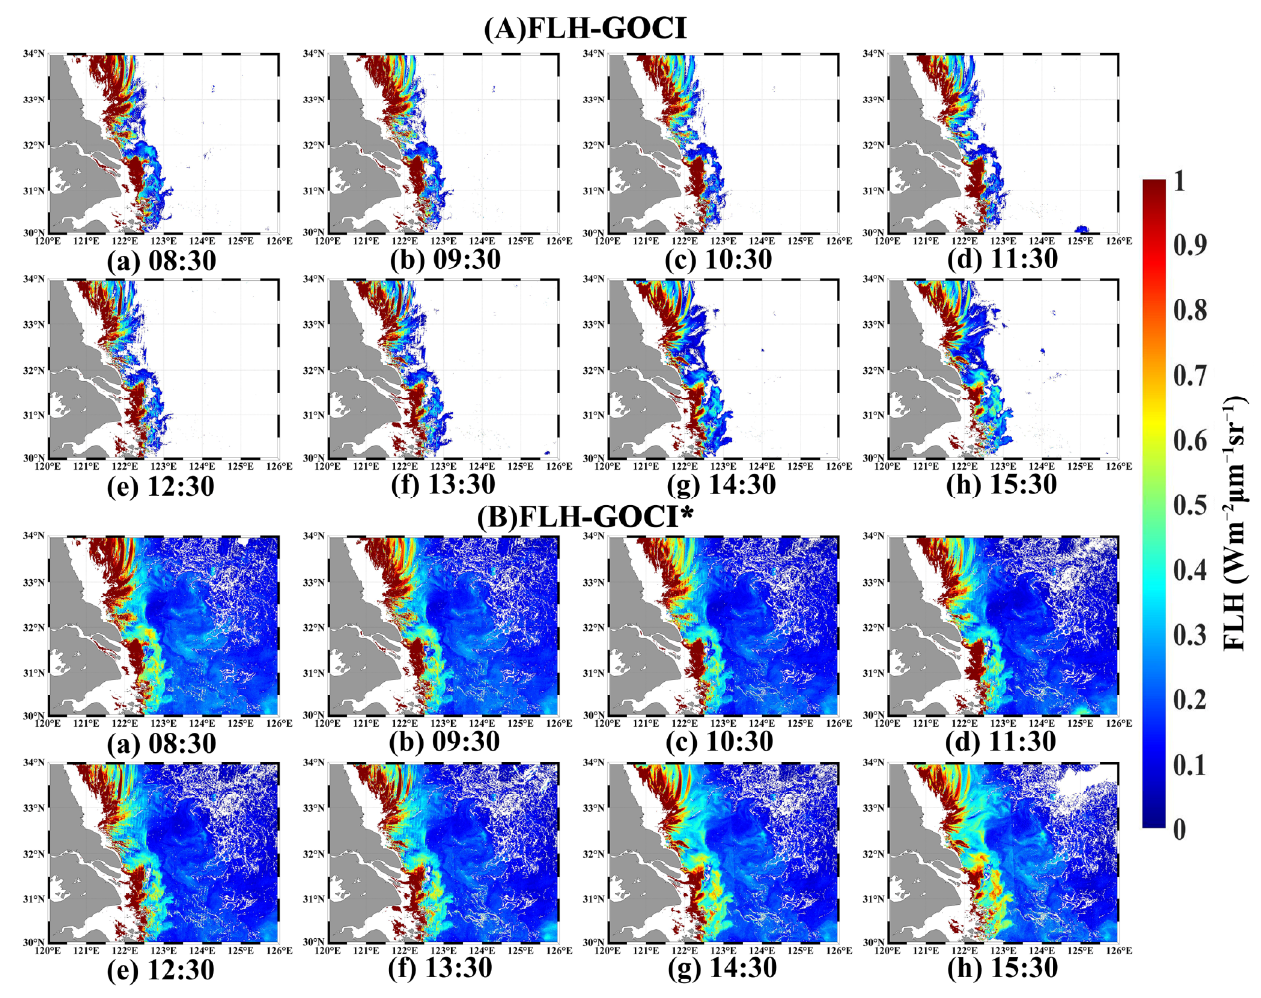
Figure 11. Comparison of FLH products generated using the pre-improved (FLH-GOCI) and post- improved (FLH-GOCI*) algorithms for 8 images per day from GOCI (18 May 2017). Table 5. Effective data coverage (in percent) before and after the improvement of the FLH algorithm of GOCI. (The ratio of the effective value to the number of all pixels in the area is taken as the coverage of the effective value.)